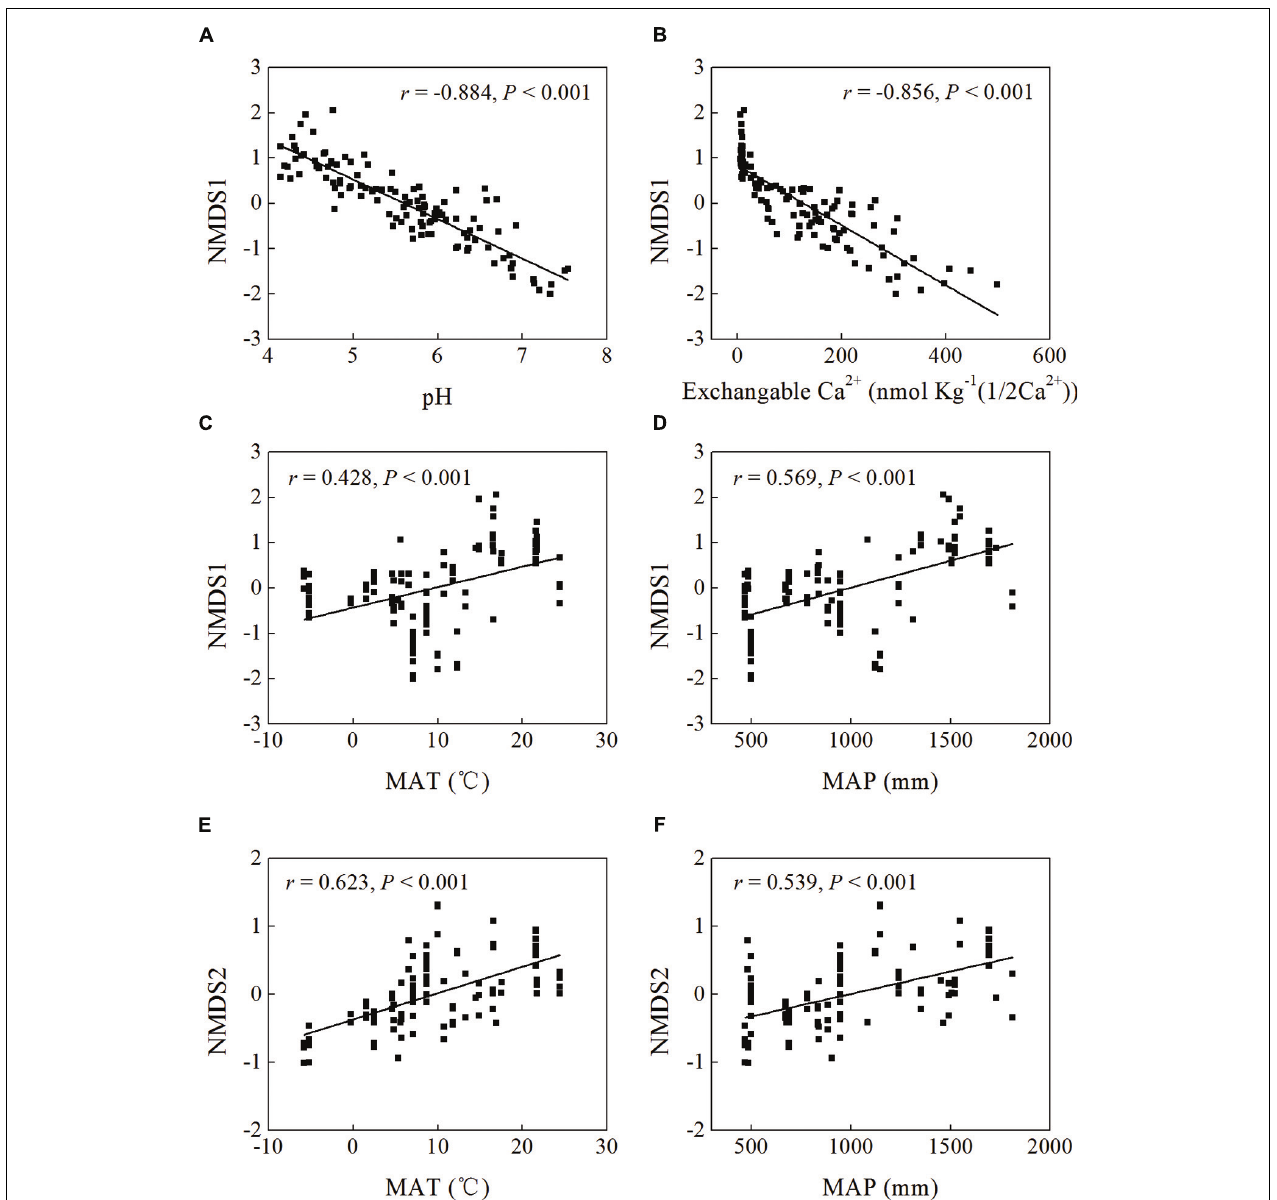
FIGURE 6 | Linear regression between non-metric multidimensional scaling (NMDS) scores (NMDS1 or NMDS2) and soil pH (A), exchangeable Ca 2 + content (B), and MAT (C,E) and MAP (D,F) of sampling